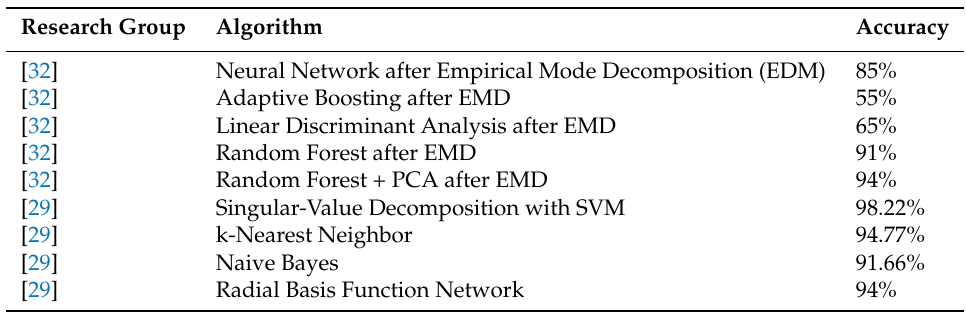
Table 2. Feature extraction techniques for hand movement classification applied to the EMG dataset from the University of California at Irvine (UCI) machine learning